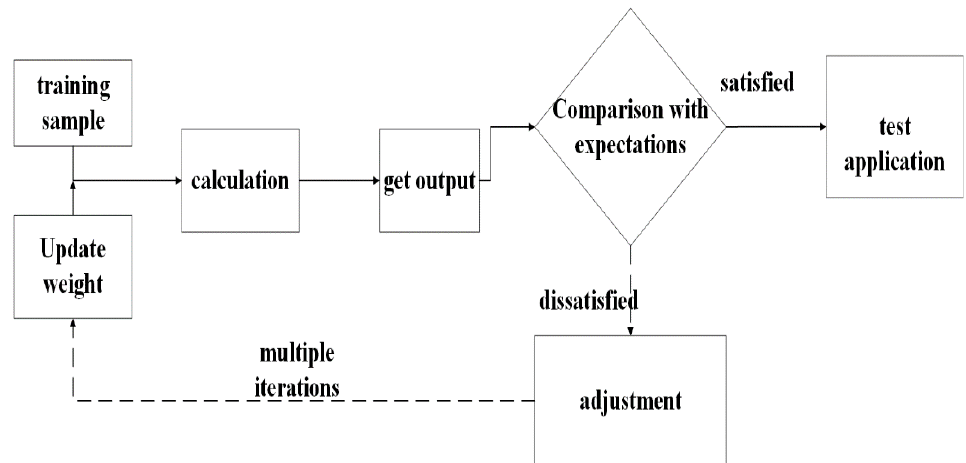
Figure 6. Neural network optimization process.